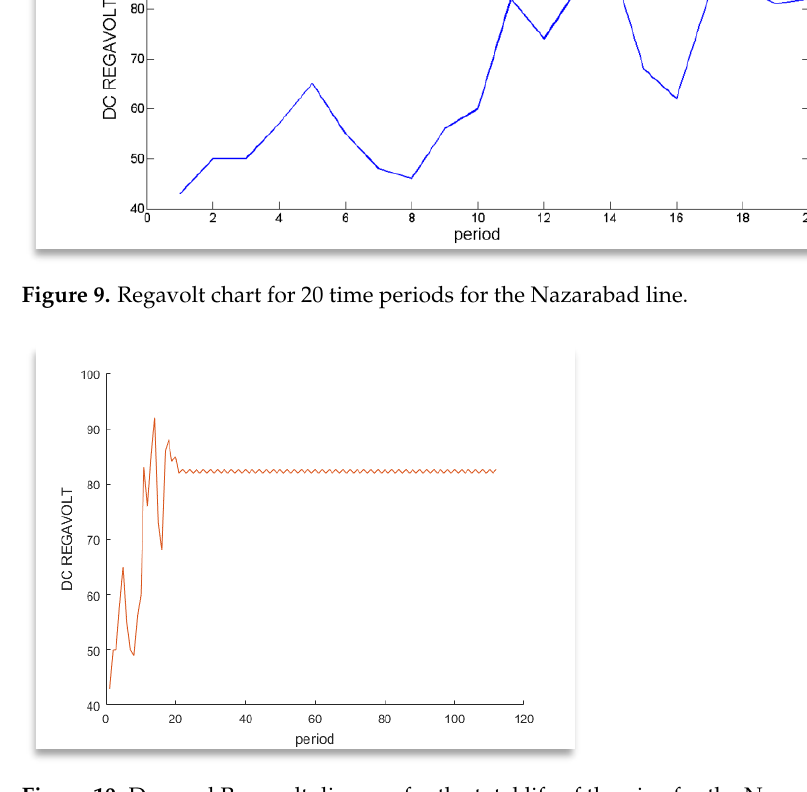
Figure 10. Damped Regavolt diagram for the total life of the pipe for the Nazarabad line.